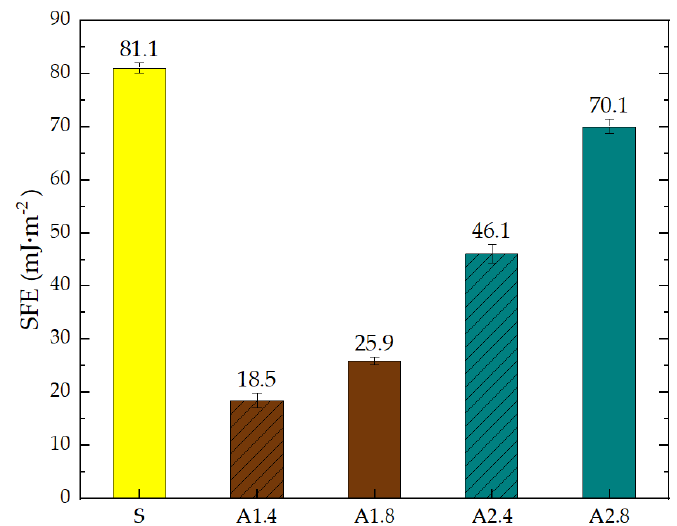
Figure 4. Surface free energy (SFE) of standard mortar (S) and with hydrophobising agents calculated based on Owens-Wendt method.